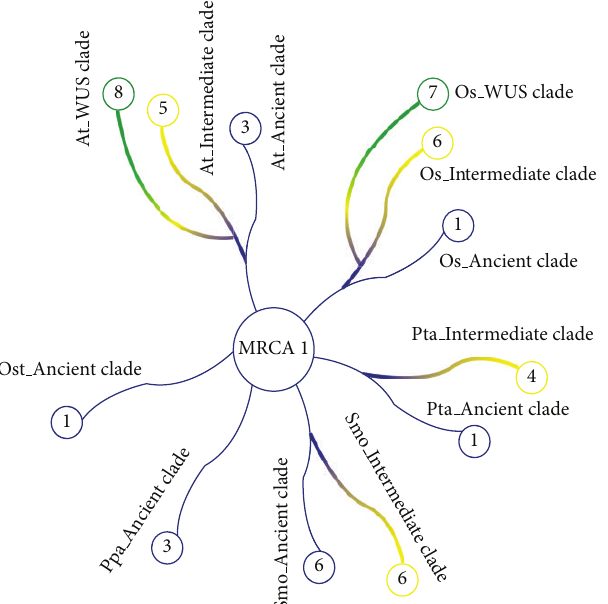
Figure 7: Evolutionary change of the number of WOX proteins in model plants. The numbers in circles represent the numbers of genes in extantspecies.Ost: Ostreococcustauri ,Ppa: Physcomitrellapatens ,Smo: Selaginellamoellendorffii ,Pta: Pinustaeda ,Os: rice ,andAt: Arabidopsis thaliana